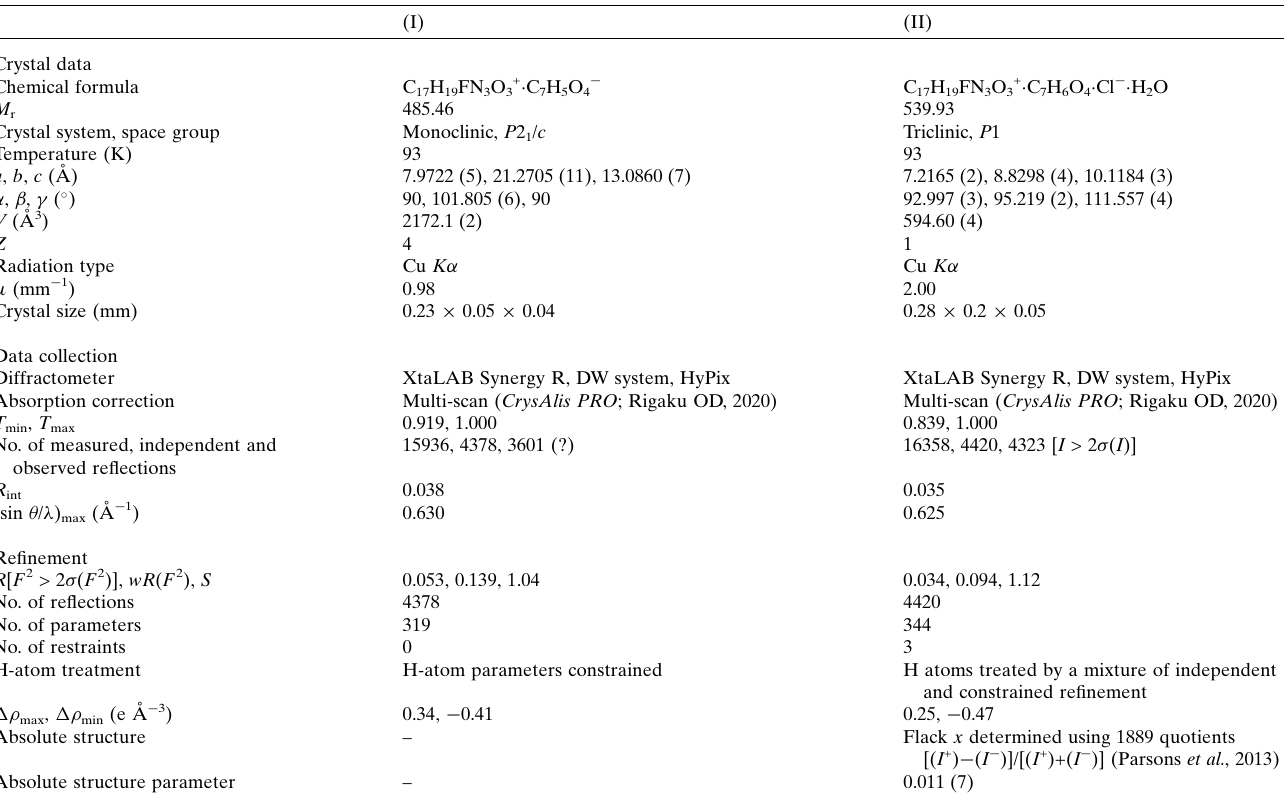
Table 3 Experimental details.